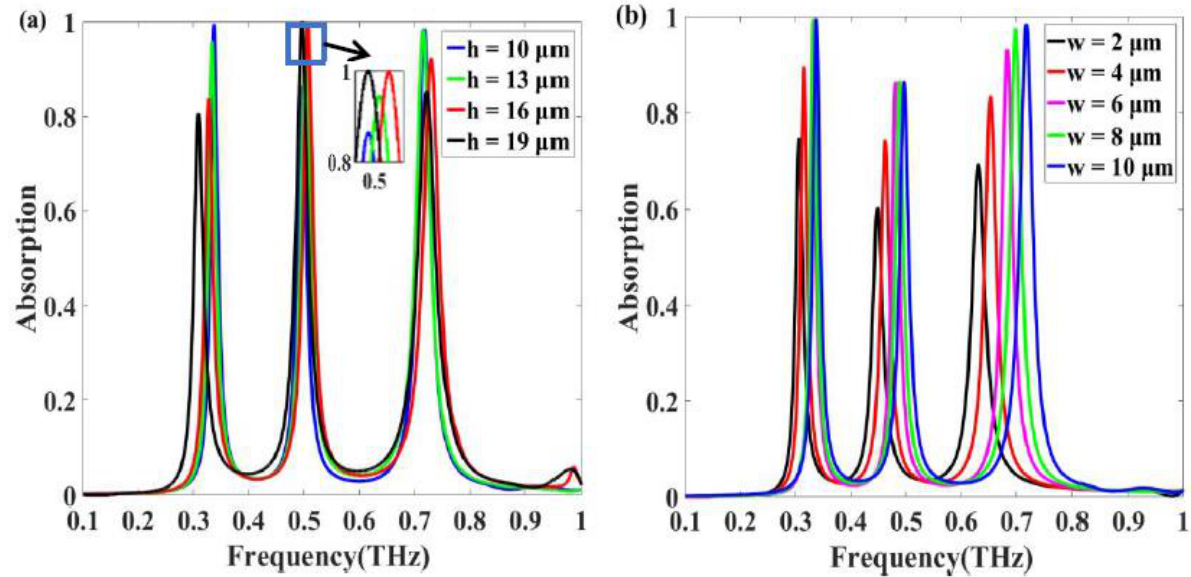
Figure 6. Simulated absorption spectra of the absorber with ( a ) four different thickness values h of PET layer; ( b ) five different widths w of resonators consisting of three concentric square rings.